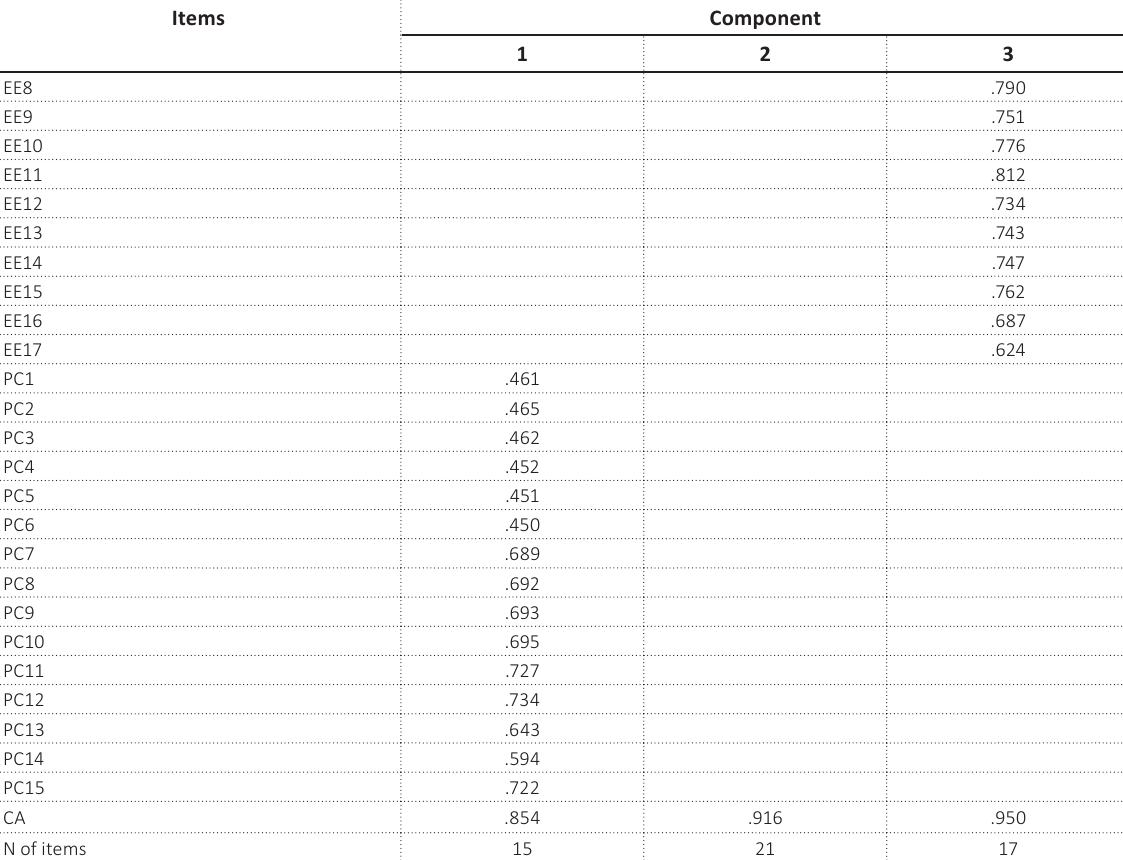
Table 3. Descriptive statistics and Pearson correlations among variables